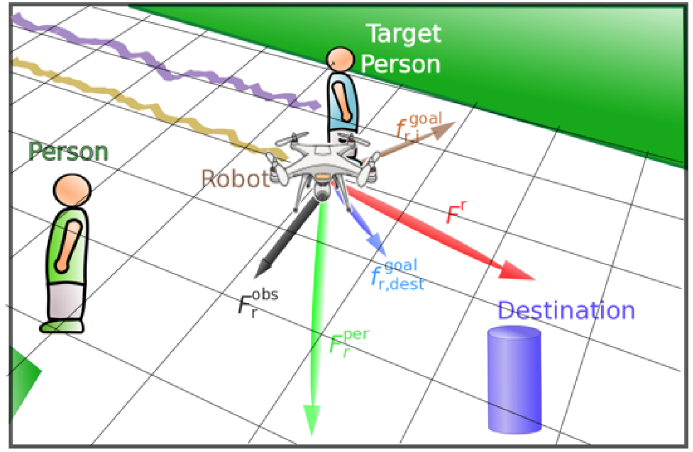
Figure 3. SFM, forces applied to the drone while accompanying a